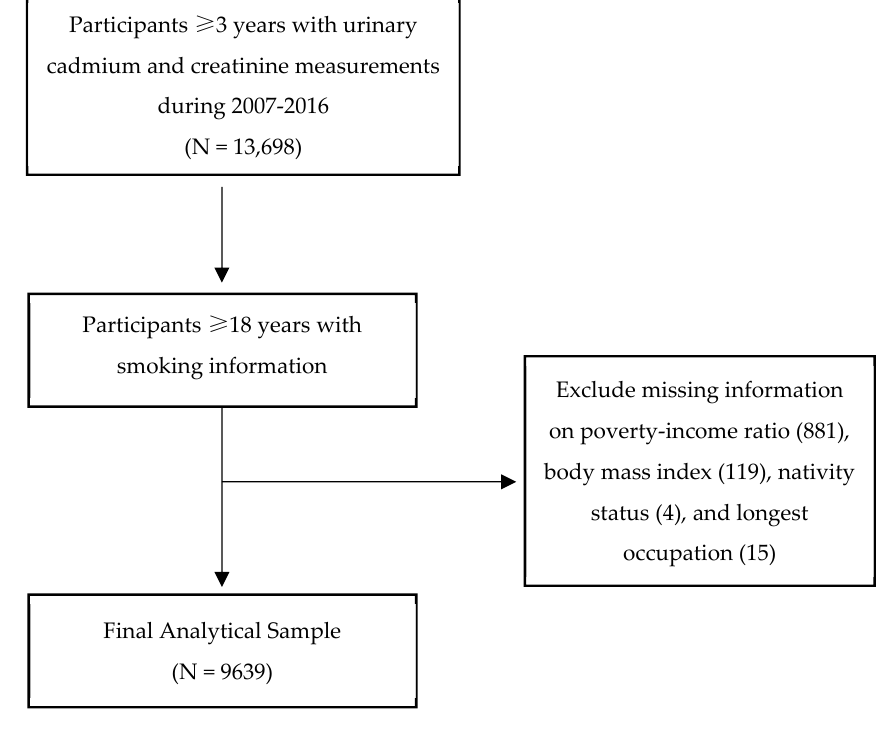
Figure 1. Participant